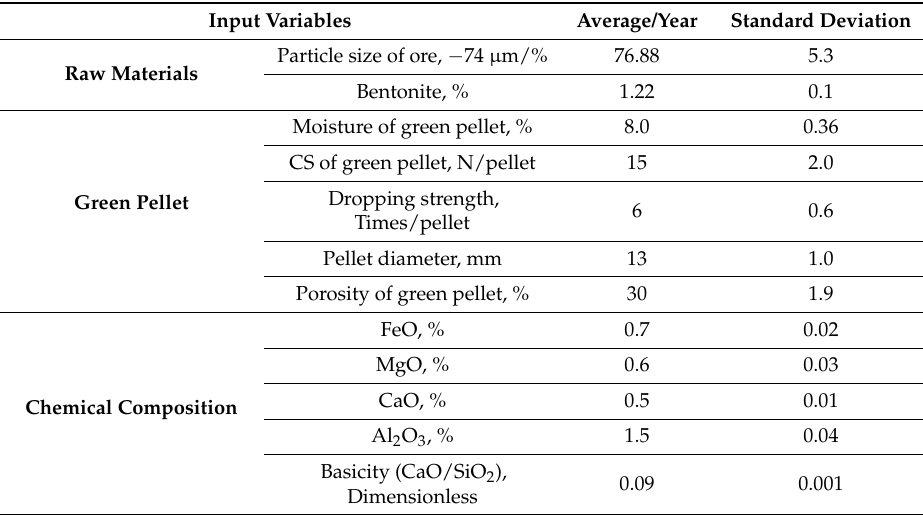
Table 1. Initial input variables of the pelletizing process.